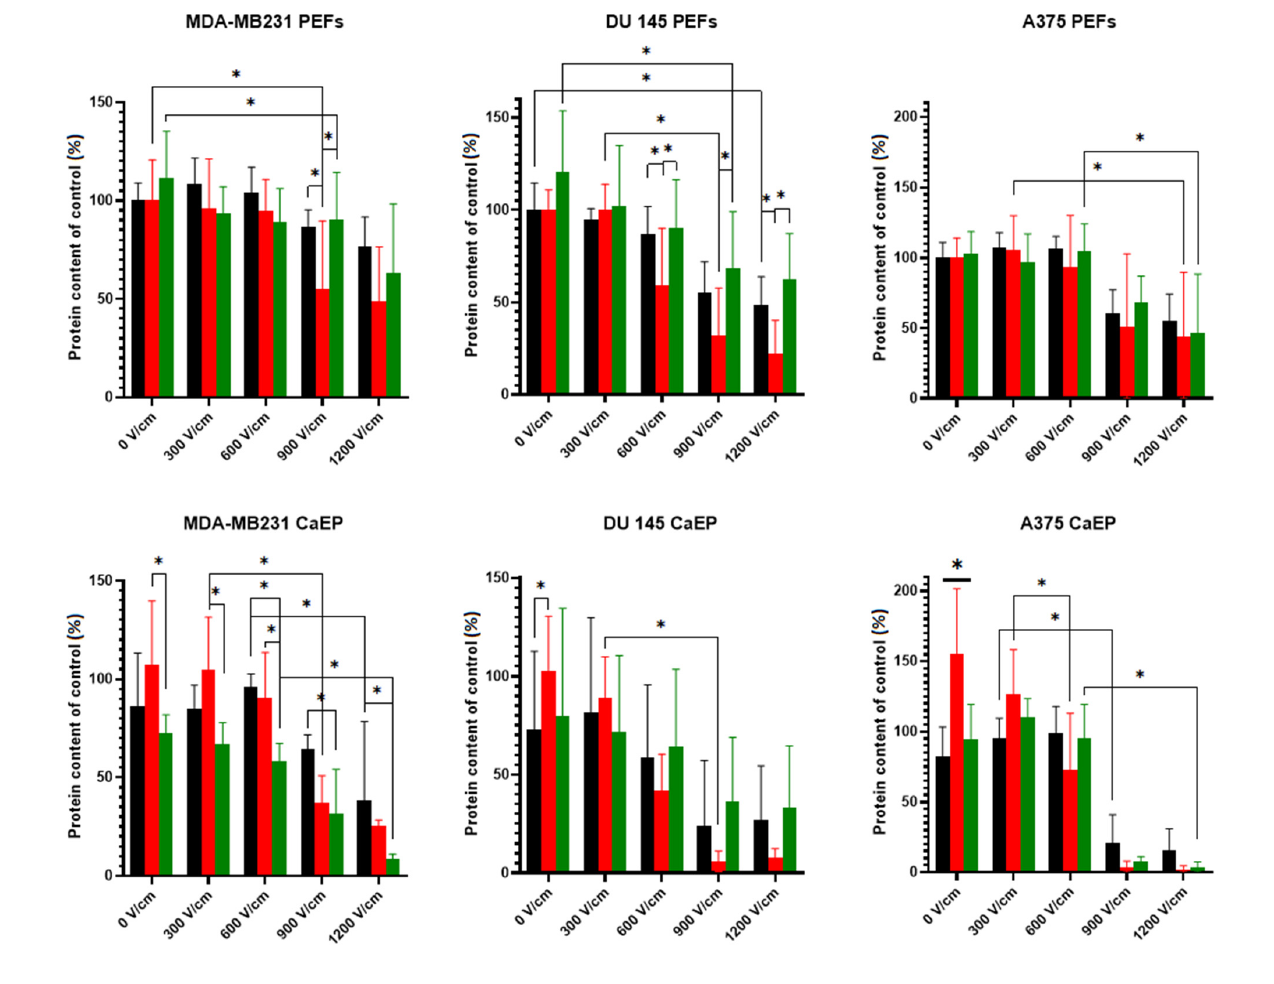
Figure 5. SRB assay. The total protein content in the cells measured 72 h after PEF with and without 5 mM calcium ions on MDA-MB231, DU 145, and A375 cell lines. Black bars: cells without atorvastatin; red bars: cells preincubated with 50 nM atorvastatin for 48 h before PEF treatment (long-term effects); green bars: the cells which were treated with 50 nM atorvastatin directly in the electroporation buffer (short-term effects). All the data were calculated as the % of untreated cells, i.e., without 0 V/cm PEF and without the addition of calcium ions. Data presented as mean ± SD, * p < 0.05 (15 > n > 5). On average, the cells preincubated with 50 nM atorvastatin reacted differently with low and high voltage PEFs. We observed that the response of the cells was different to the therapy, depending on the applied electric field intensity. Namely, in low voltages, the total protein in the cells preincubated with atorvastatin remained increased and with the elevating electric field intensity, the total protein content decreased in comparison to control cells.